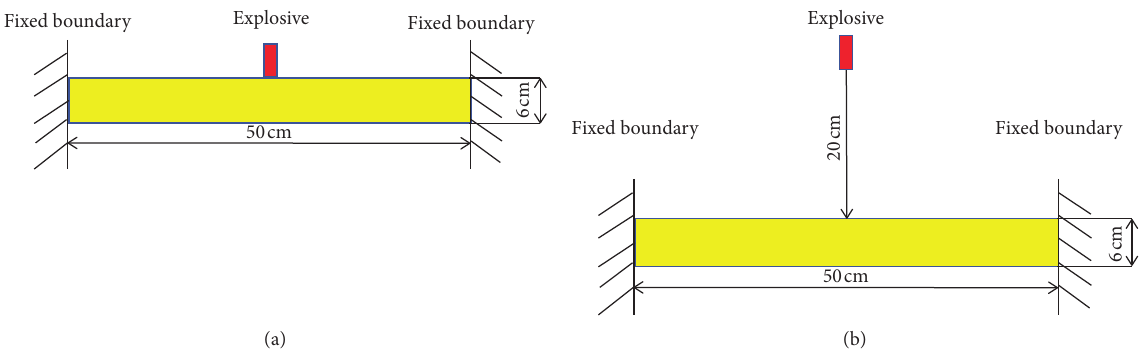
Figure 6: Simplified diagram of (a) air contact and (b) close-in explosion.